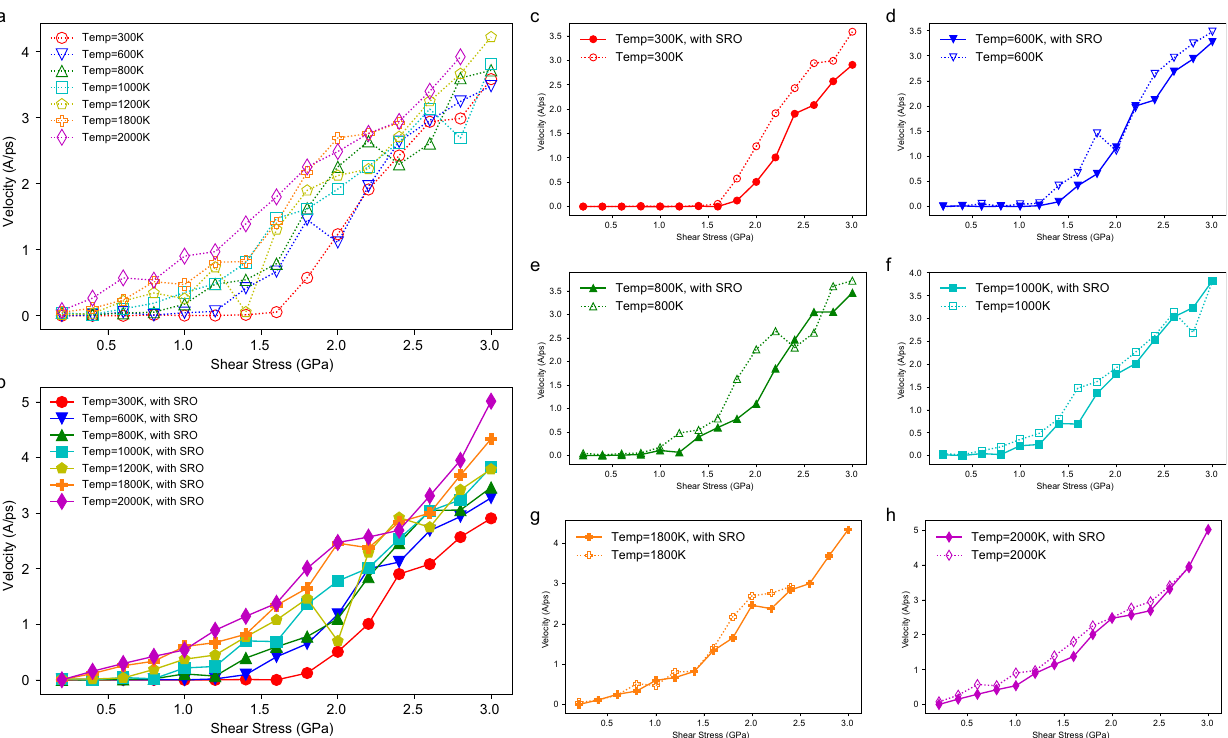
Fig. 2 The effect of SRO on the velocities of screw dislocations. a Velocities of screw dislocations in the RSS sample as a function of applied shear strain. b Velocities of screw dislocations versus shear stress in the sample with local chemical SRO equilibrated at 800 K. c – h Detailed comparisons of the in fl uence of SRO at different temperatures from 300 to 2000 K. Lines between scattered data are guides to the eyes and do not correspond to fi ts of theoretical 4 τ ¼ γ = b , where 4 τ is the stress increment due to SRO and DAPB from b is the Burgers vector. Using the value of the γ DAPB